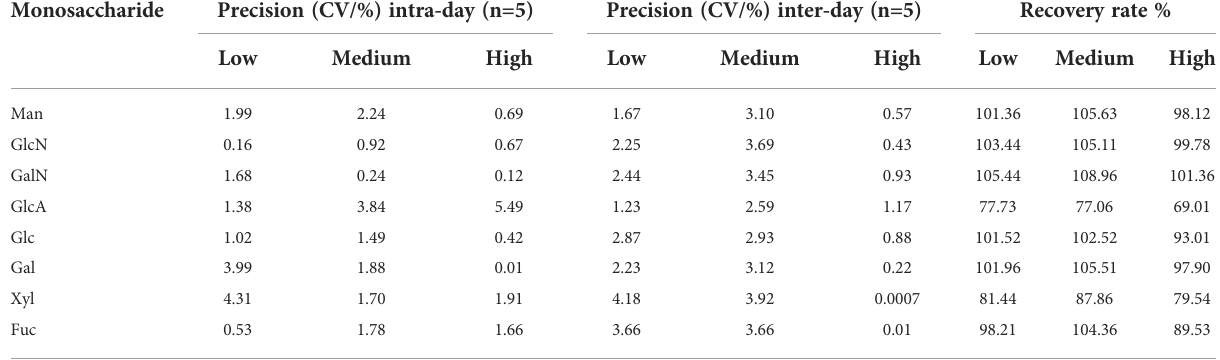
TABLE 2 Recovery rate, and precision of the method in quality controls at low, medium, and high